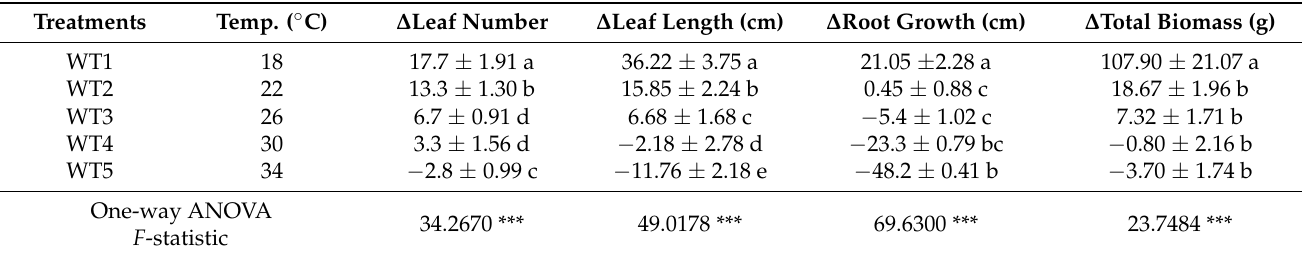
Table 2. The interaction of various root zone water temperatures on the overall vegetative growth of S. formosus. Treatments